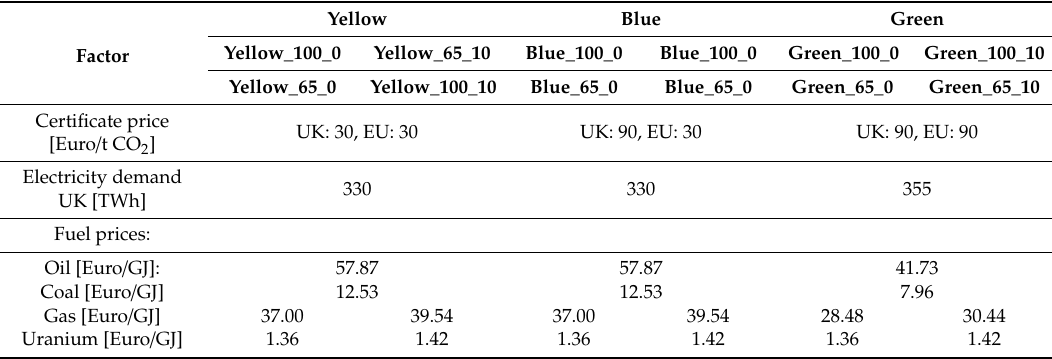
Table 2. Key parameters for the scenarios. Source: Own compilation, based on ENTSO-E